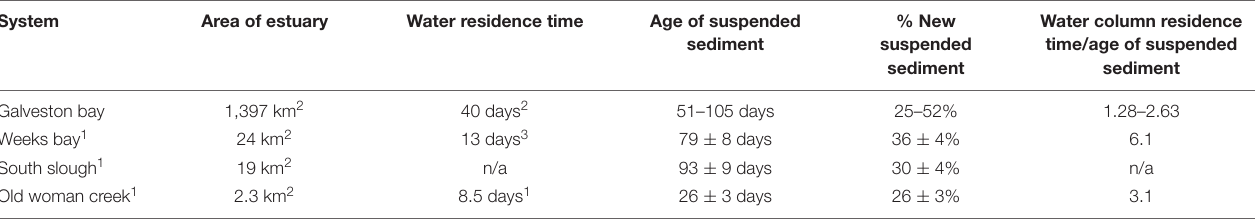
TABLE 3 | Summary of areas, water residence times, age and % new suspended